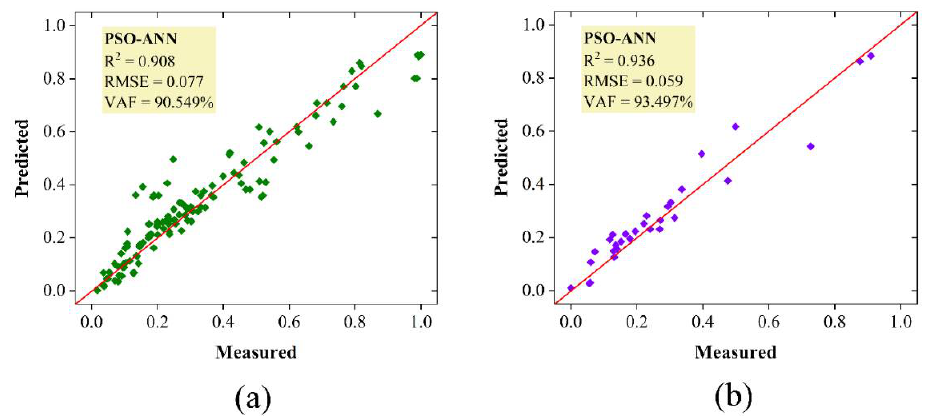
Figure 14. The results bearing capacity of the SCFST columns by PSO-ANN; ( a ) training, ( b ) testing.